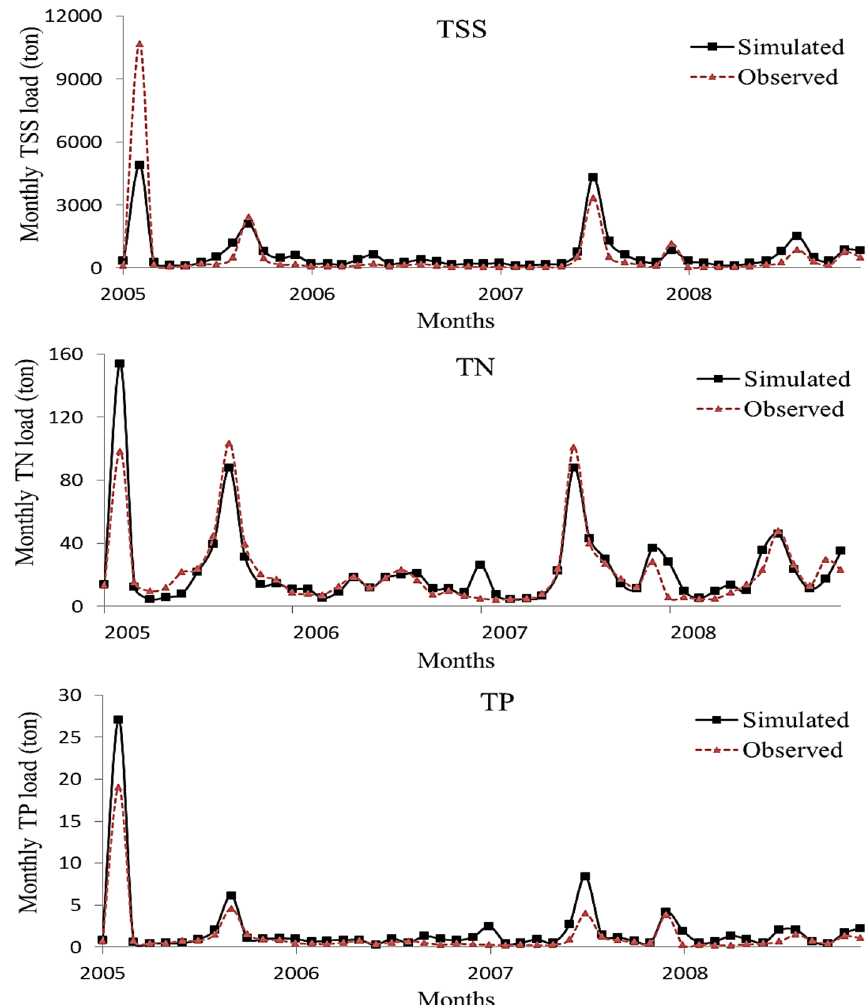
Fig. 6 Validation between simulated and observed monthly TSS, TN and TP in the